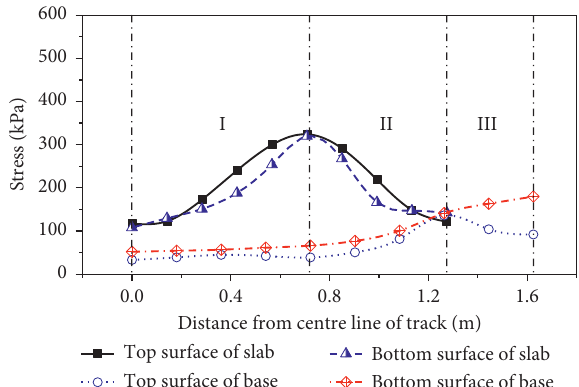
Figure 8: Spatial distribution of dynamic structural stress along the lateral